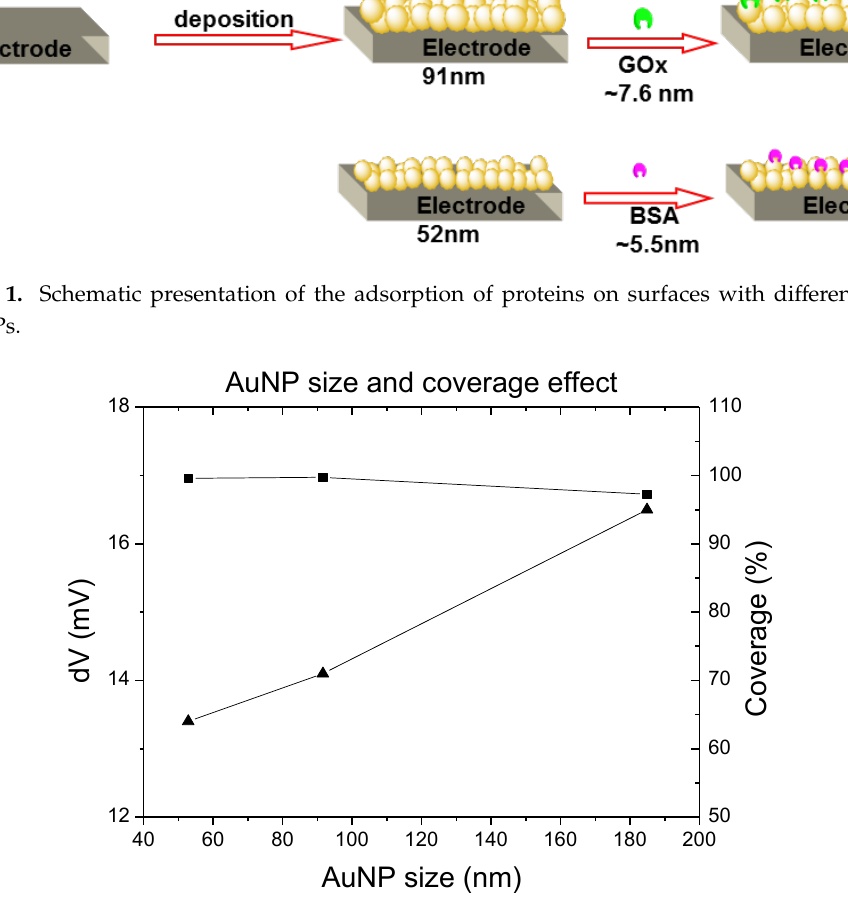
Figure 5. The effect of AuNPs size to amperomatric response and AuNP surface coverage.